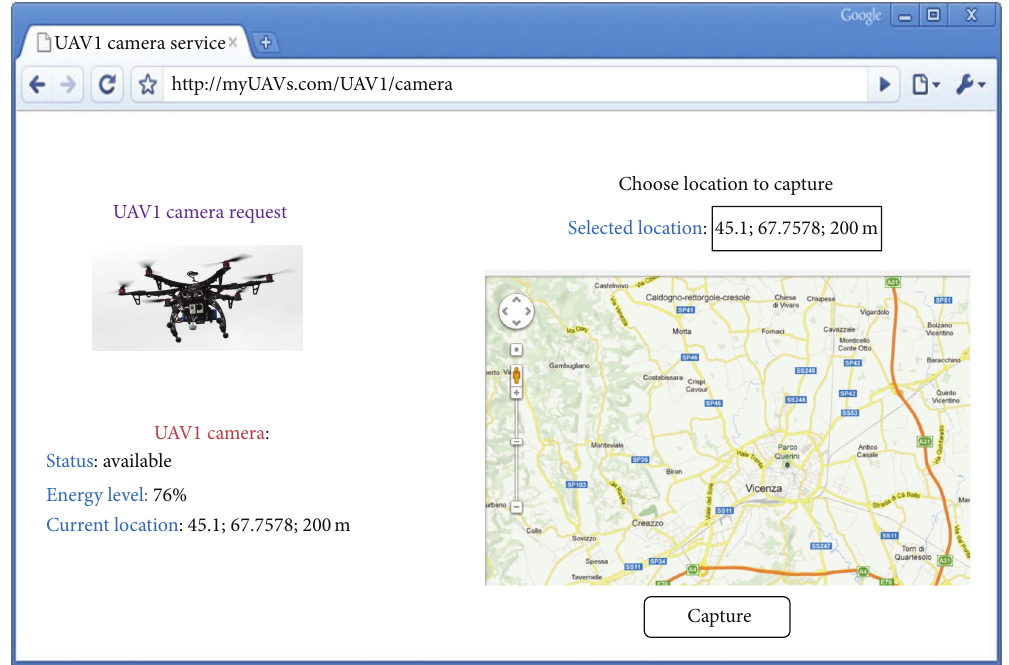
Figure 4: Client user interface application for requesting camera service from